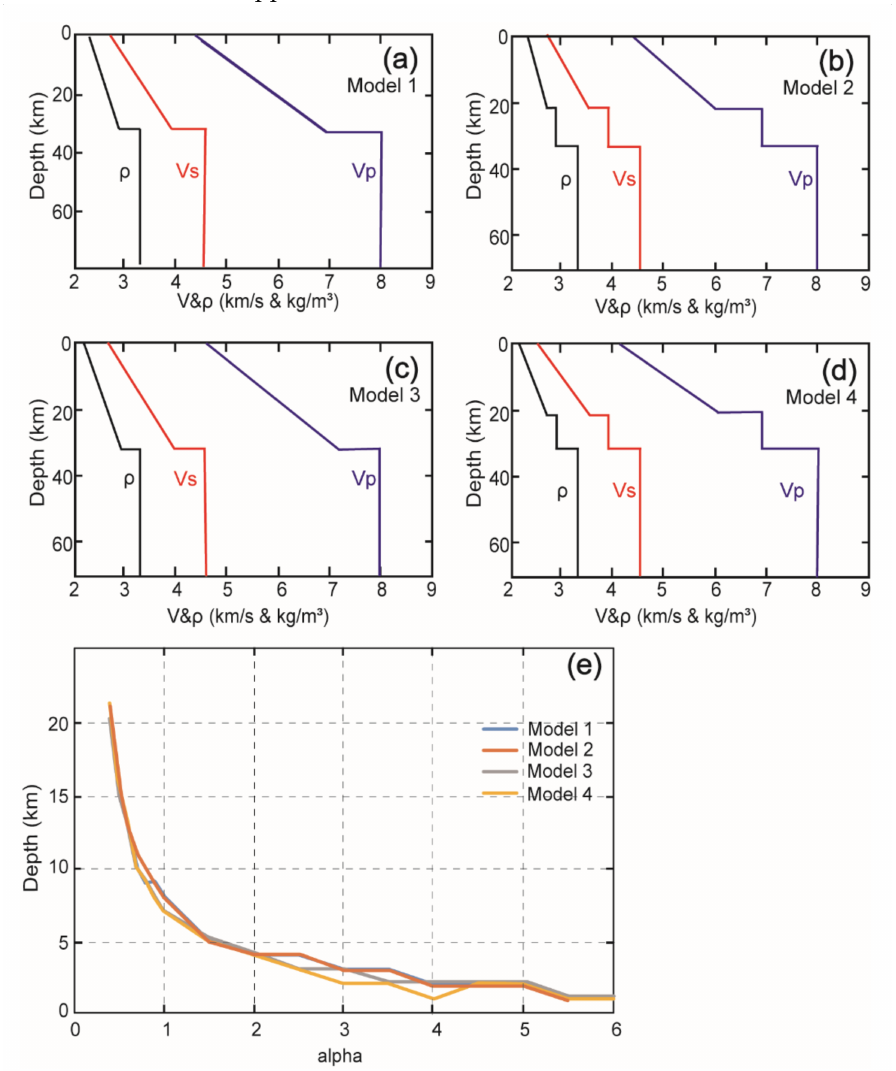
Figure 3. Gaussian filtering factors (alpha) corresponding to SWVs at different depths. ( a – d ) Crustal structure model with different velocity-density values; ( e ) test results of the